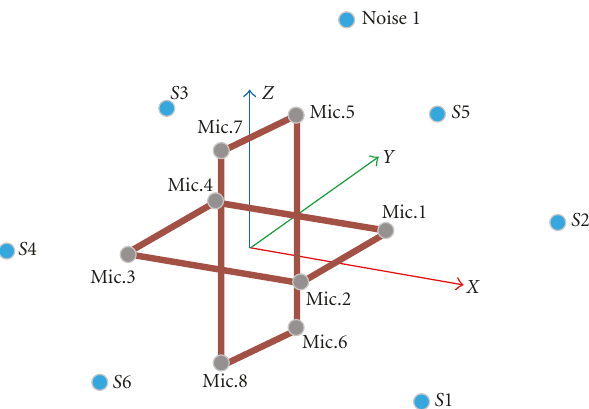
Figure 7: Arrangement of microphone array and sound sources.